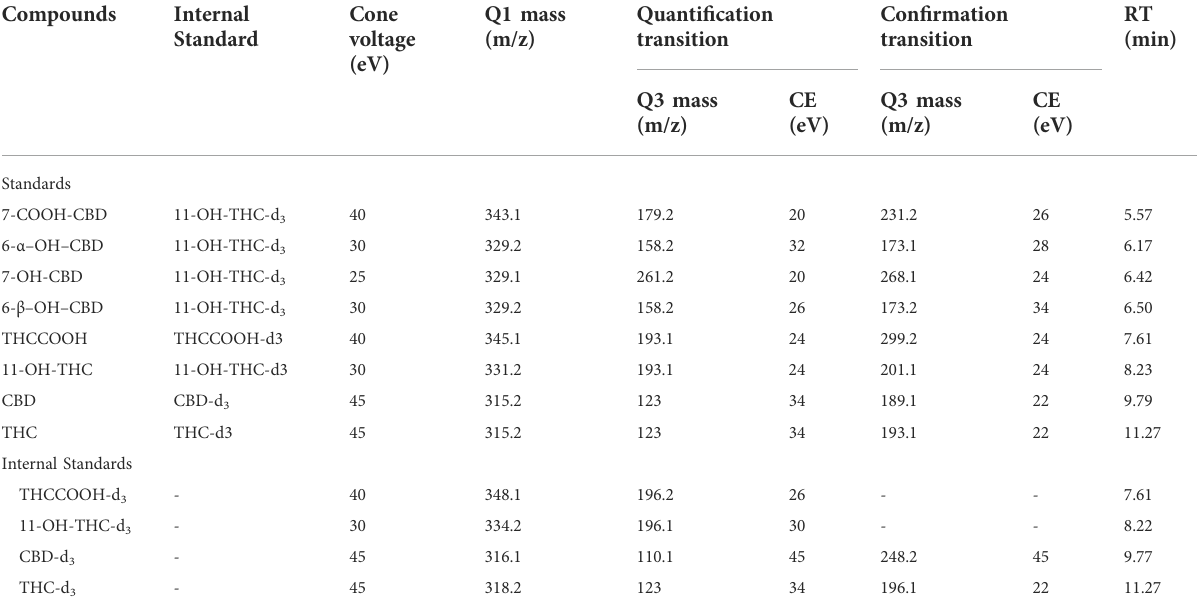
TABLE 1 Mass spectrometry parameters for analytes and internal standards.